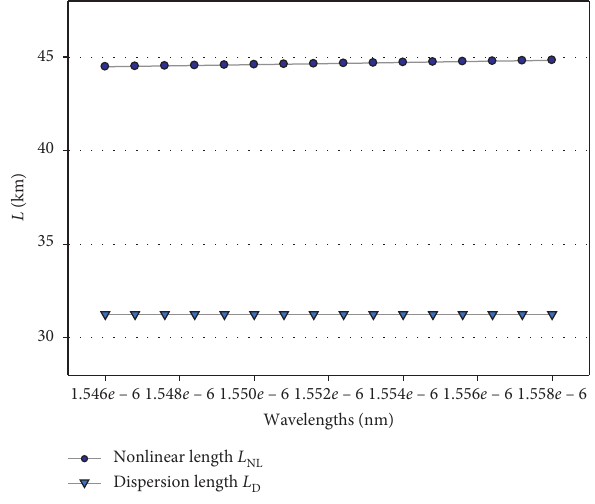
Figure 6: Output signal amplitudes for different values of input power.